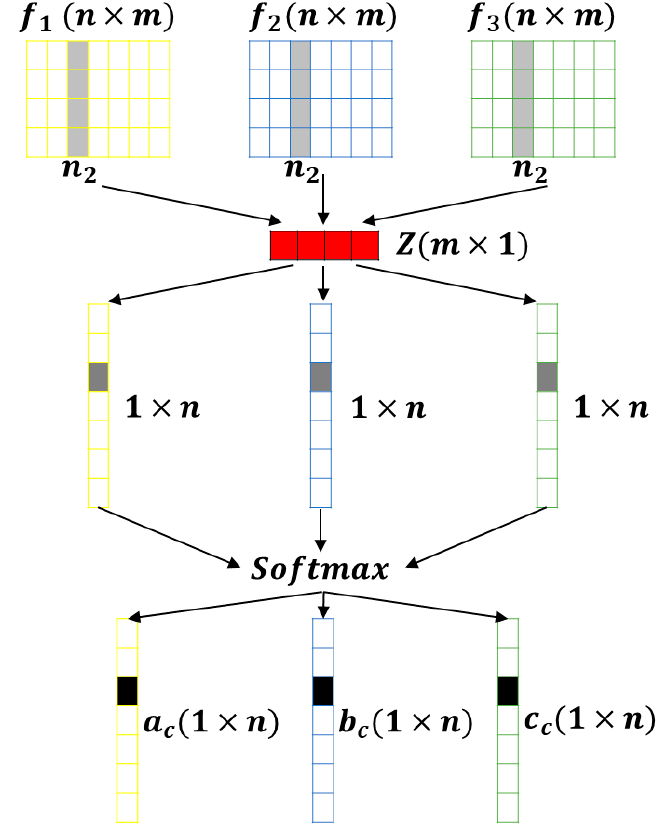
Figure 5. Information capture for cross-channel interactions in LMCA-Net with 1D convolution. Finally, the three separately obtained masks are multiplied by the corresponding F 1 , F 2 , and F 3 to obtain F (cid:48) 1 , F (cid:48) 2 , and F (cid:48) 3 . These three feature modules are summed and combined with the residuals of the original feature F for information fusion to obtain the final feature module F (cid:48)(cid:48) as in Equation (3), which has been refined compared with the original F and fused with information from multiple sensory